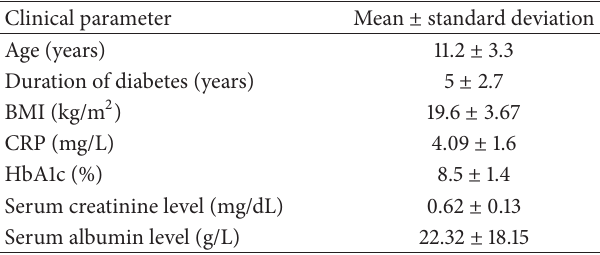
Table 1: Clinical characteristics of patients with type 1